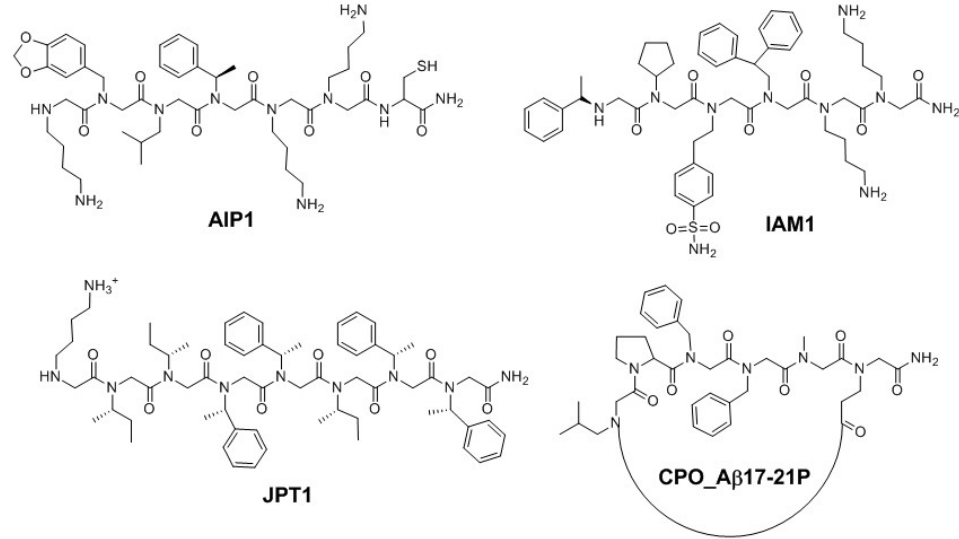
Figure 2. Structures of antiamyloidogenic peptoids AIP1 [40], IAM1 [41,42], JPT1 [43,44,47], and CPO_A β 17-21P [50]. Protonation states are the same as those shown in the original references.